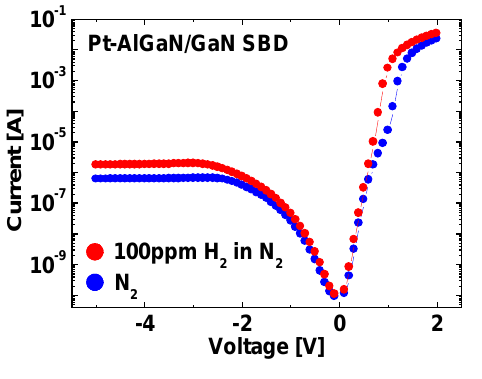
Figure 13. I-V characteristics of the device in N in N at room 2